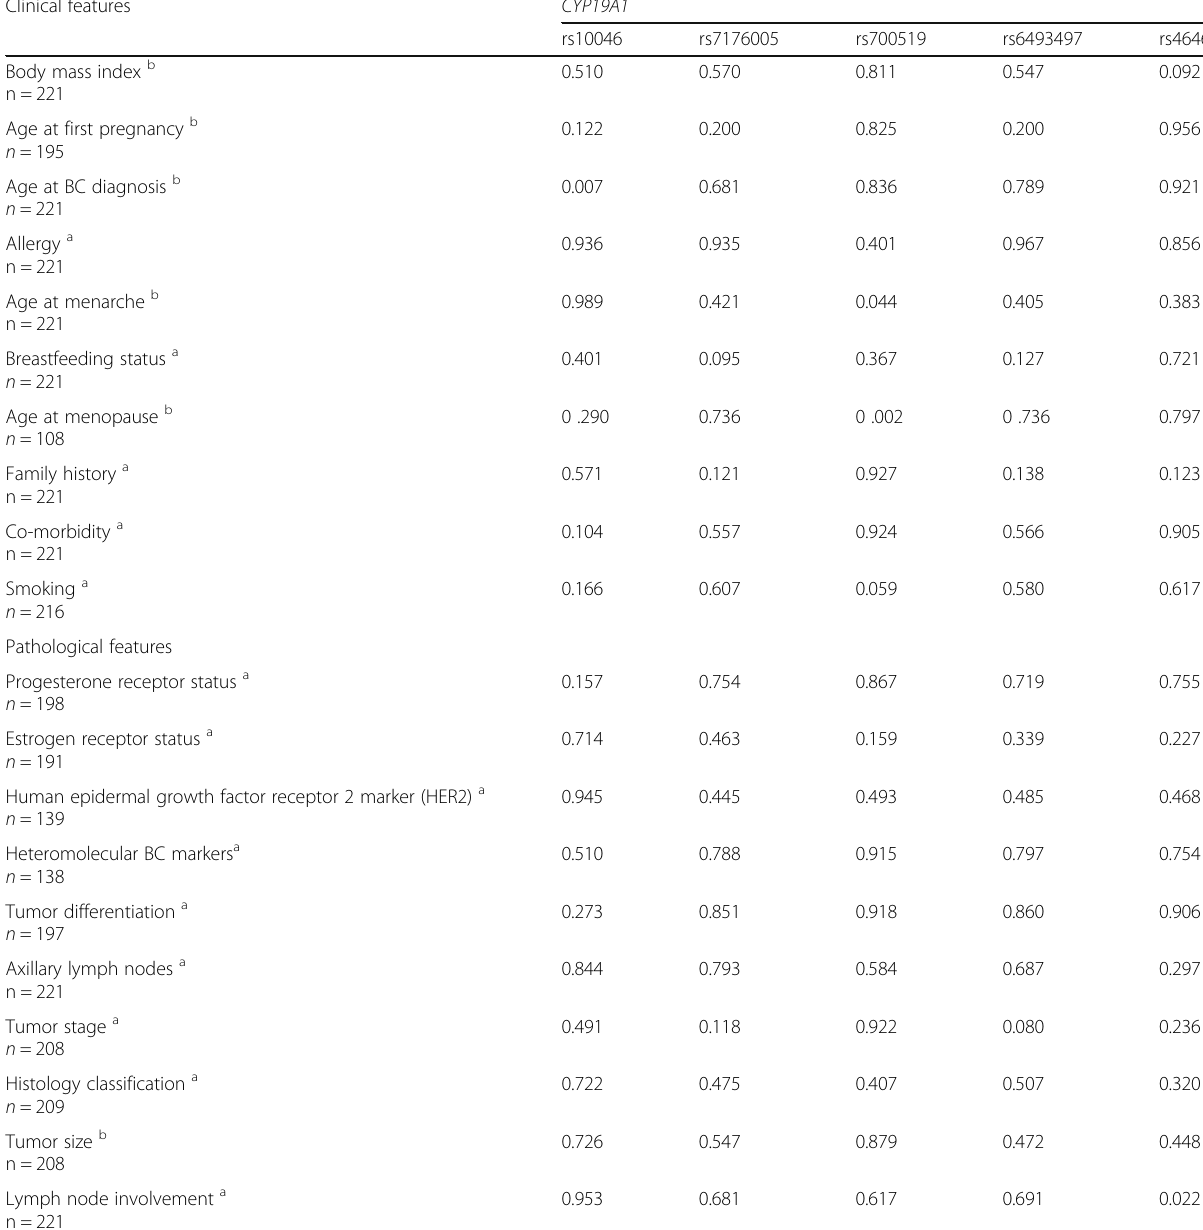
Table 5 Association between different CYP19A1 SNP genotypes and the clinico-pathological features of breast cancer (BC) Clinical